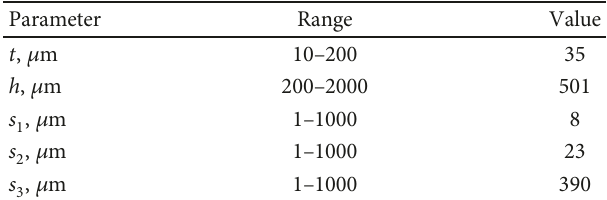
Figure 12: Voltage waveforms at the input ( – · – ) and output ( — ) (with enlarged fragment of the signal at the output) of a three-conductor microstrip line MF after the four-criterion GA optimization with the objective function (23), when amplitude criterion is less important. Table 8: Optimized parameter of the MF for N = 4 , their ranges, and values after optimization with respect to the matching criterion with equal weighing coe ffi